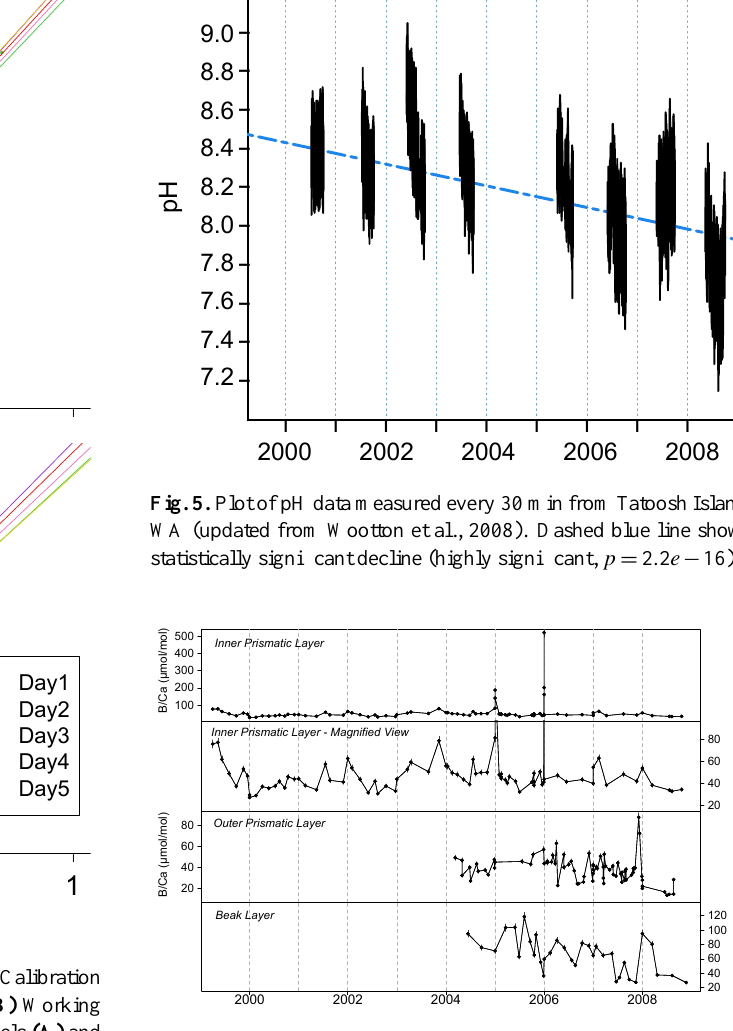
ture, with an r 2 of 0.256 ( p = 0 . 0031 using 5-day data bin; r 2 = 0 . 192, p = 0 . 018 for pH using 9-day data bin) (Fig. 7). This model fit with both temperature and pH was statistically significant, to the 0.001 level with temperature and 0.01 level with pH. As mentioned, the sinusoidal fit is consistent